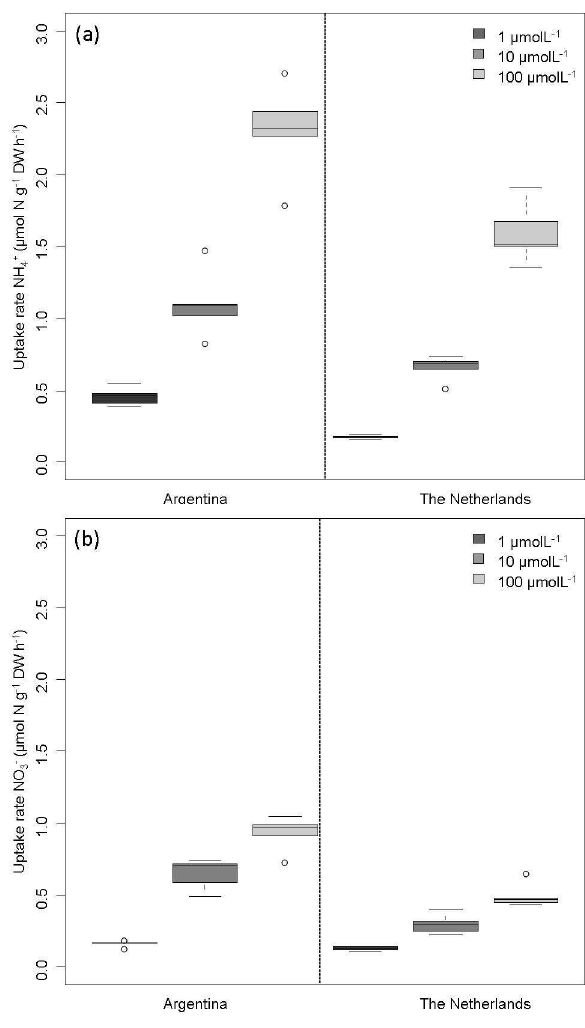
Figure 4. Differences in uptake rates ( m mol N gDW 2 1 h 2 1 ) were dependent on the origin of the mosses. N-Uptake rates are shown at 1 m M (dark grey), 10 m M (grey) and 100 m M (light grey), respectively, of the pristine site (Argentina, left) and the N-polluted site (The Netherlands, right). Upper panel (a) shows ammonium (NH 4 + ) uptake. The lower panel (b) shows shows nitrate (NO 3 2 ) uptake. Experiments lasted 72 hours.